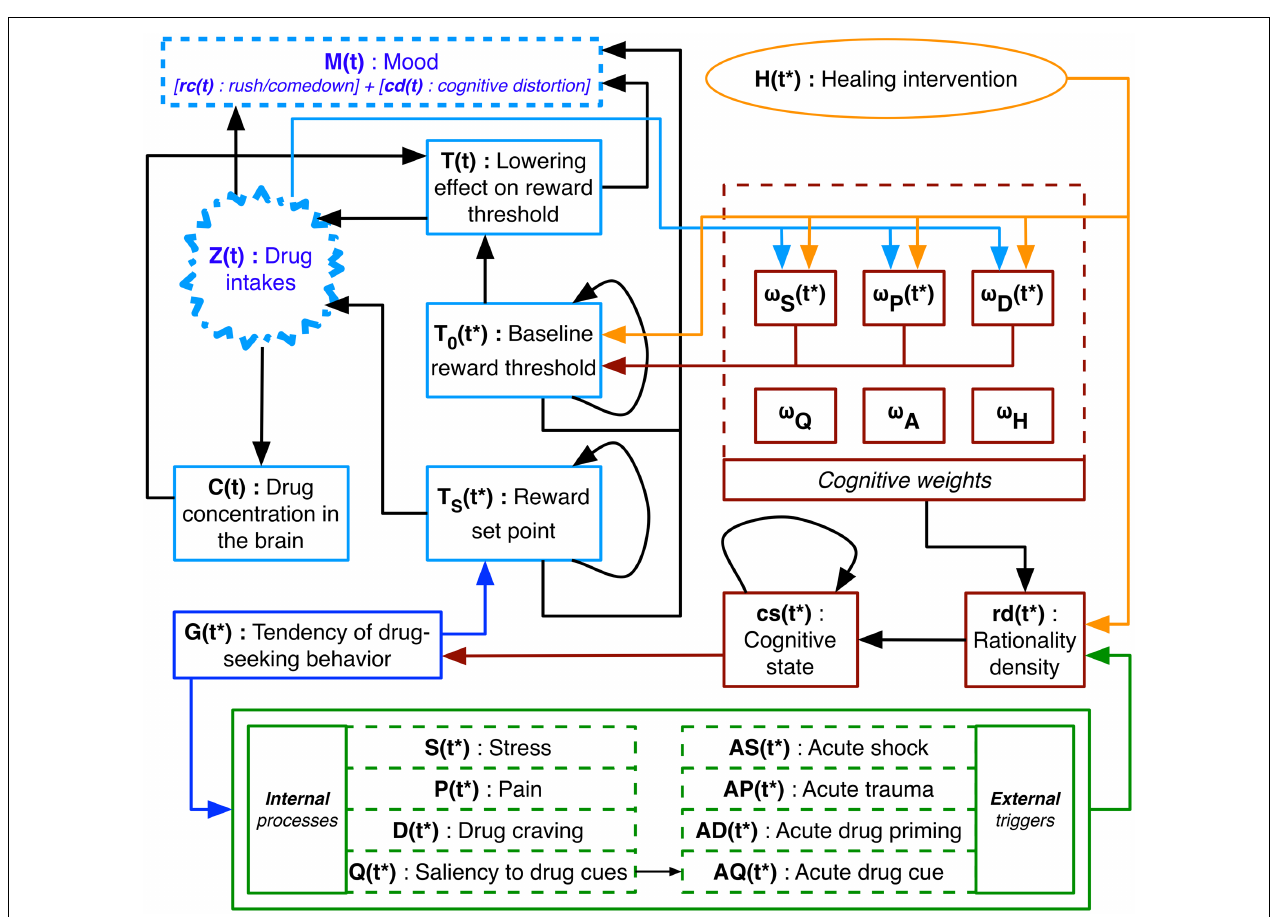
the tendency of drug-seeking behavior, G ( t *).This predisposition influences the reward set point, T S ( t *), which together with the lowering effect on reward threshold, T ( t ), defines decisions about drug intake, Z ( t ).The cognitive weights influence the baseline reward threshold, T 0 ( t *), indirectly influence T ( t ), and are affected by Z ( t ). A healing intervention has a direct impact on both cognitive learning and T 0 ( t *), and an indirect effect on T S ( t *) associated with changes in the virtual subject’s rationality density, rd ( t *).The mood M ( t ) is a combination of Z ( t ), T ( t ), T 0 ( t *), and T S ( t